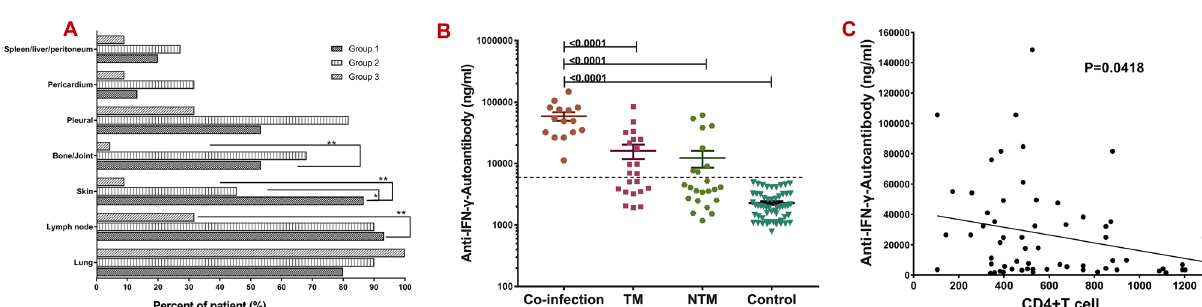
Figure 2. Comparison of sites involved among three groups. ( A ) Lymph nodes were most commonly involved (90.1%), followed by the skin (86.4%) and bone/joint (54.5%) in Groups 1 and 2. ( B ) Comparing the anti- IFN-γ autoantibodies titer between groups, titers in Groups 1, 2, and 3 were remarkably higher than the healthy volunteer group, with patients in Group 1 showing the highest anti-IFN-γ autoantibodies titer. ( C ) The correlation between AIGA titers and the number of CD4 + T